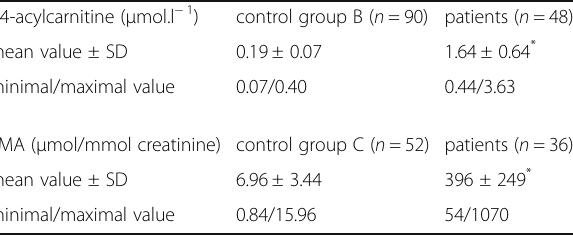
Table 4 The comparison of C4-acylcarnitine and/or EMA values in the cohort of SCAD-deficient patients and control groups B and C,